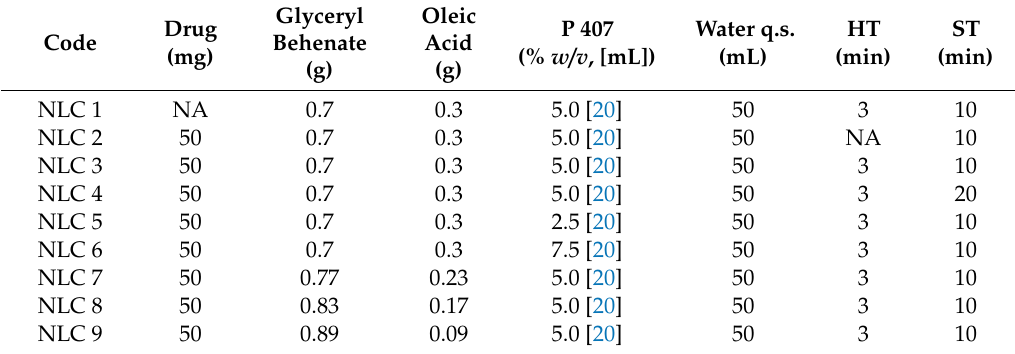
Table 1. Composition and the variables (HT-homogenization time, ST-sonication time) of various nanostructured lipid carrier (NLC) formulations for optimization. The % P407 refers to the concentration used to prepare the NLCs while the final % P407 will be lesser after the dilution to 50 mL.